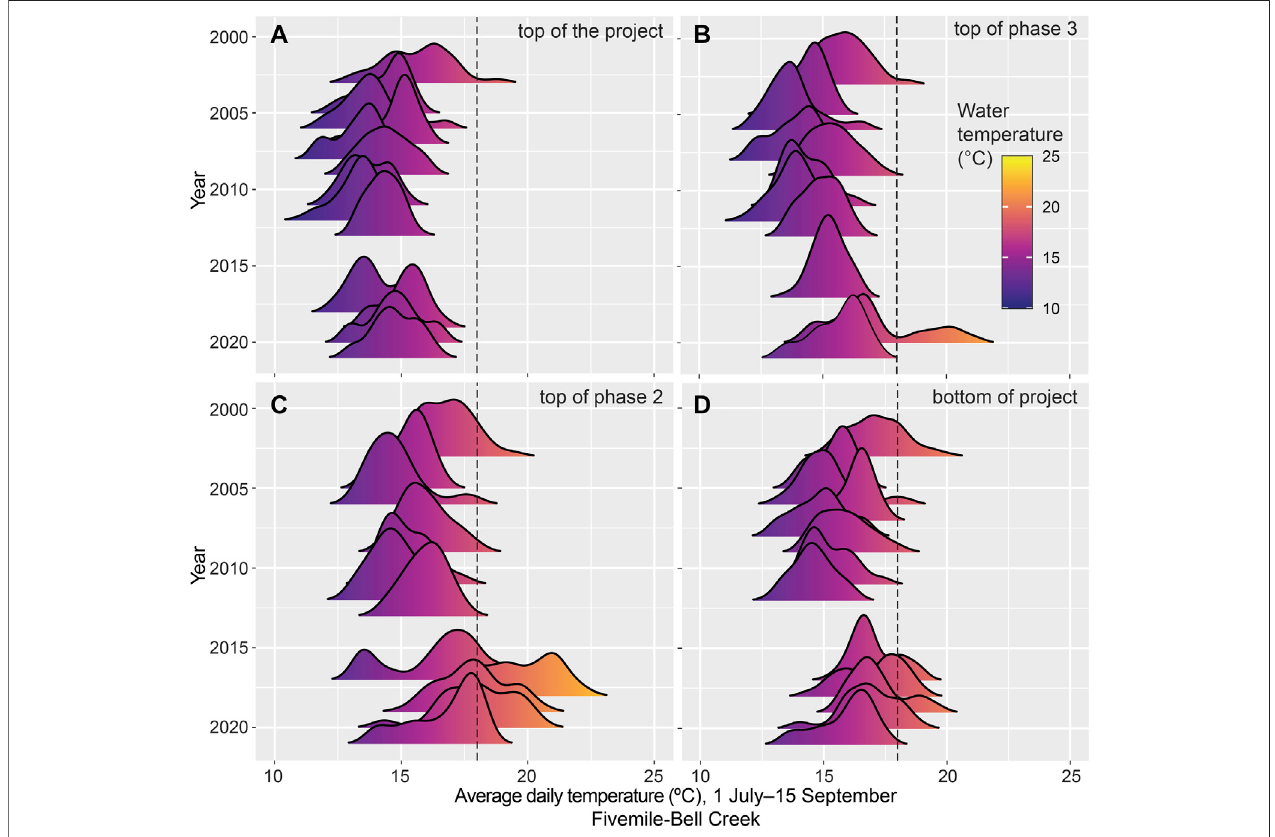
FIGURE 6 | Stream temperature over time at Fivemile Bell site that drains into Tahkenitch Lake on the south coast of Oregon, United States.